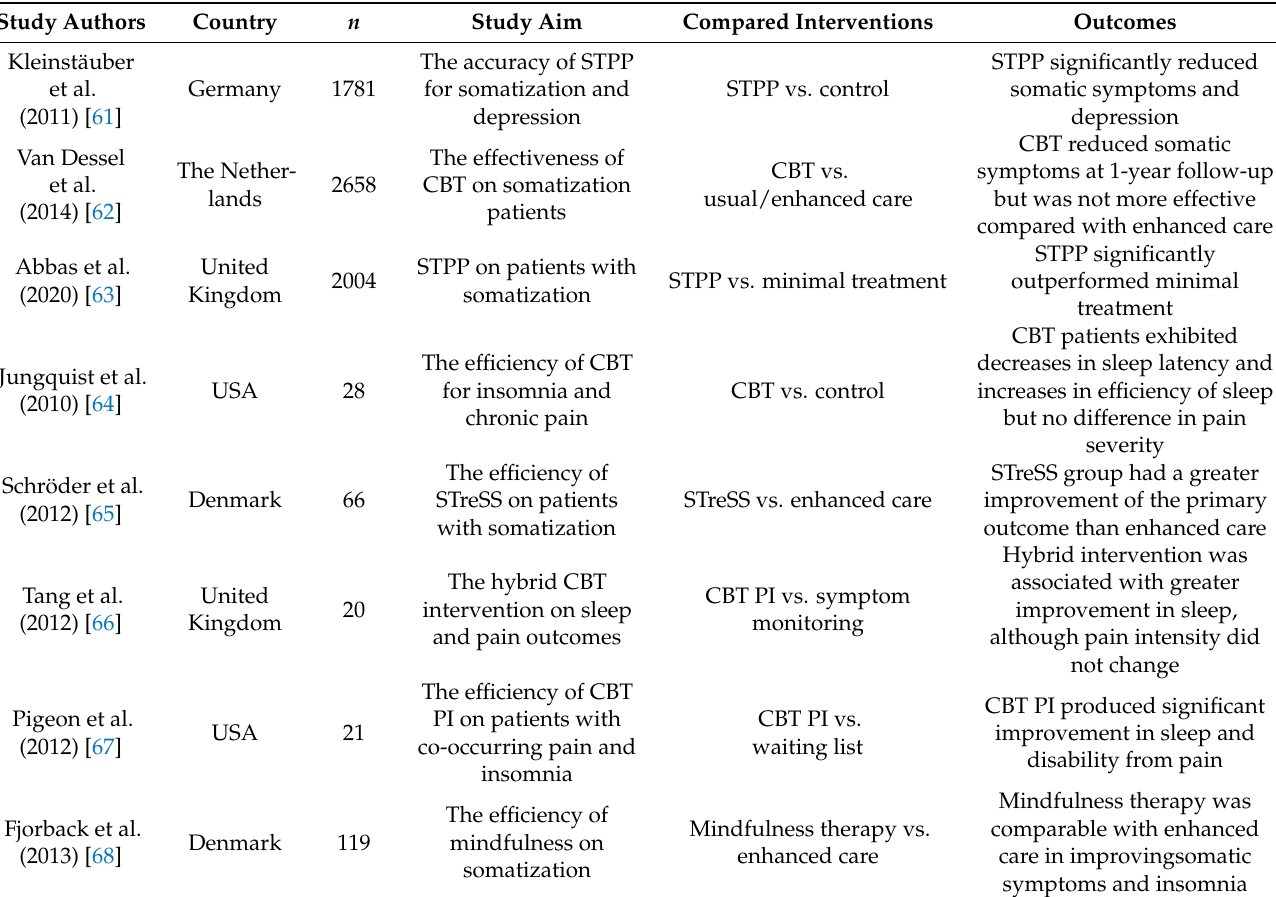
Table 4. The effect of non-pharmacological treatment on somatic symptoms and sleep